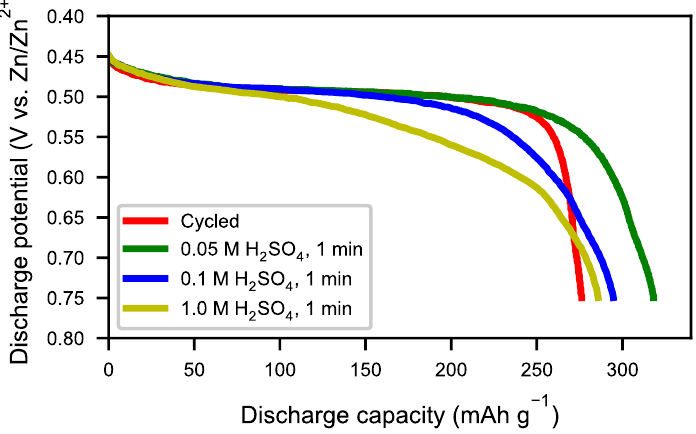
Figure 13. The discharge curves at 60 mA g −1 of cycled anodic material: cycled alloys treated with 0.05 M H 2 SO 4 for 1 min, 0.1 M H 2 SO 4 for 1 min, and 1 M H 2 SO 4 for 1 min, respectively.